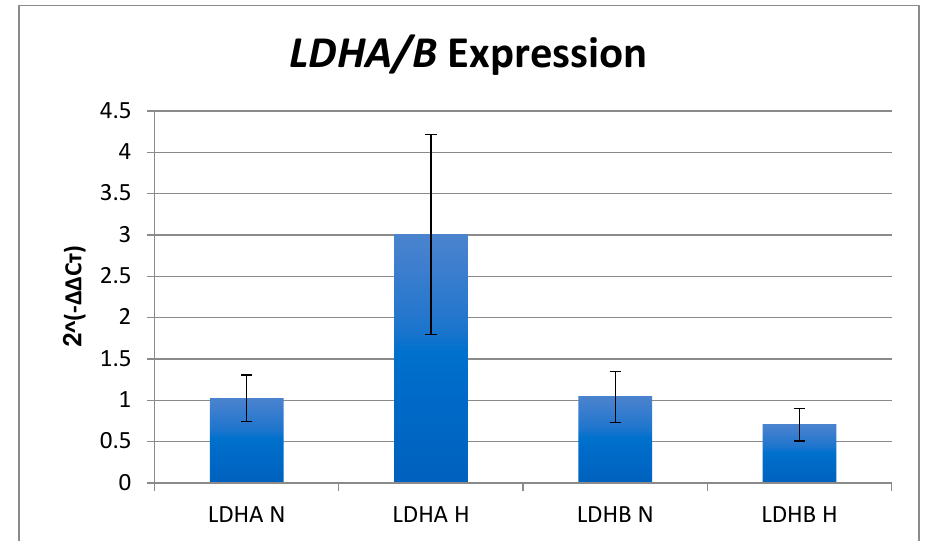
Figure 4. LDHA and LDHB expression in normoxia and hypoxia by q-RT-PCR. LDH expression was calculated for each gene using the ∆∆ CT method with ∆∆ CT representing the difference in normalized gene expression ( ∆ CT = CT:LDH-CT: β actin) using mean ∆ CT for the normoxic condition as the calibrator value. Fold change in gene expression was calculated via log transformation (2 − ∆∆ CT). Mean 2 − ∆∆ CT values are presented with +/ − 1 SD for the normoxic (N) and hypoxic (H) conditions. LDHA expression was significantly increased in hypoxia compared to normoxia (p = 0.0026 by the one-tailed Mann–Whitney U test). LDHB expression was significantly decreased in hypoxia compared to normoxia (p = 0.033 by the one-tailed Mann–Whitney U test). DrugBank analysis searched a subset of the hypoxia-upregulated DEGs (601 with p < 0.01) with its target database and identified four molecules targeting genes upregulated in hypoxic T98G cells: tenecteplase (adjusted p = 0.013, 5 gene targets), succinic acid (p = 0.02, 7 gene targets), artenimol (p = 0.013, 13 gene targets), and copper (p = 0.0015, 22 gene targets). The specific genes are listed in Supplementary Table